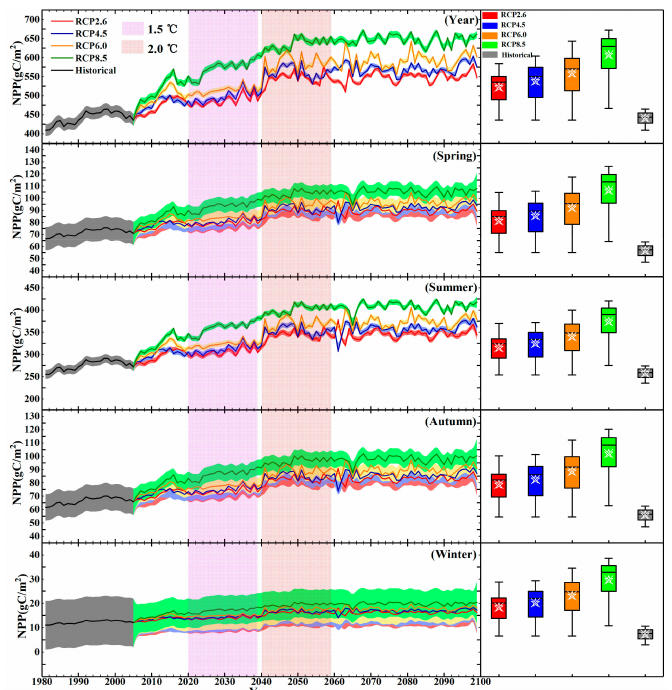
Figure 4. Temporal variation in NPP changes under GW_1.5 ◦ C_2.0 ◦ C levels from 1980 to 2100 and the di ff erence in NPP between warming levels for the whole year, spring (March, April, and May), summer (June, July, and August), autumn (September, October and November), and winter (December, January, and February). The horizonal lines in each boxplot represent the minimum, 25th percentile, median, 75th percentile and maximum NPP, respectively, and the stars represent the average NPP. All results were derived from CASA model